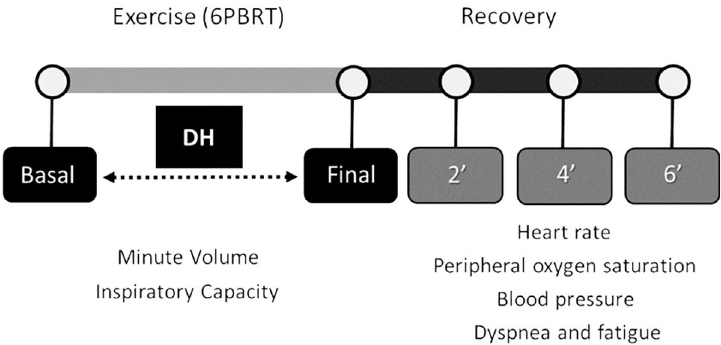
Fig 1. Symptoms, ventilator and hemodynamics measurements during and after 6-PBRT. Abbreviations: 6-PBRT, six-minute pegboard and ring test; DH, dynamic